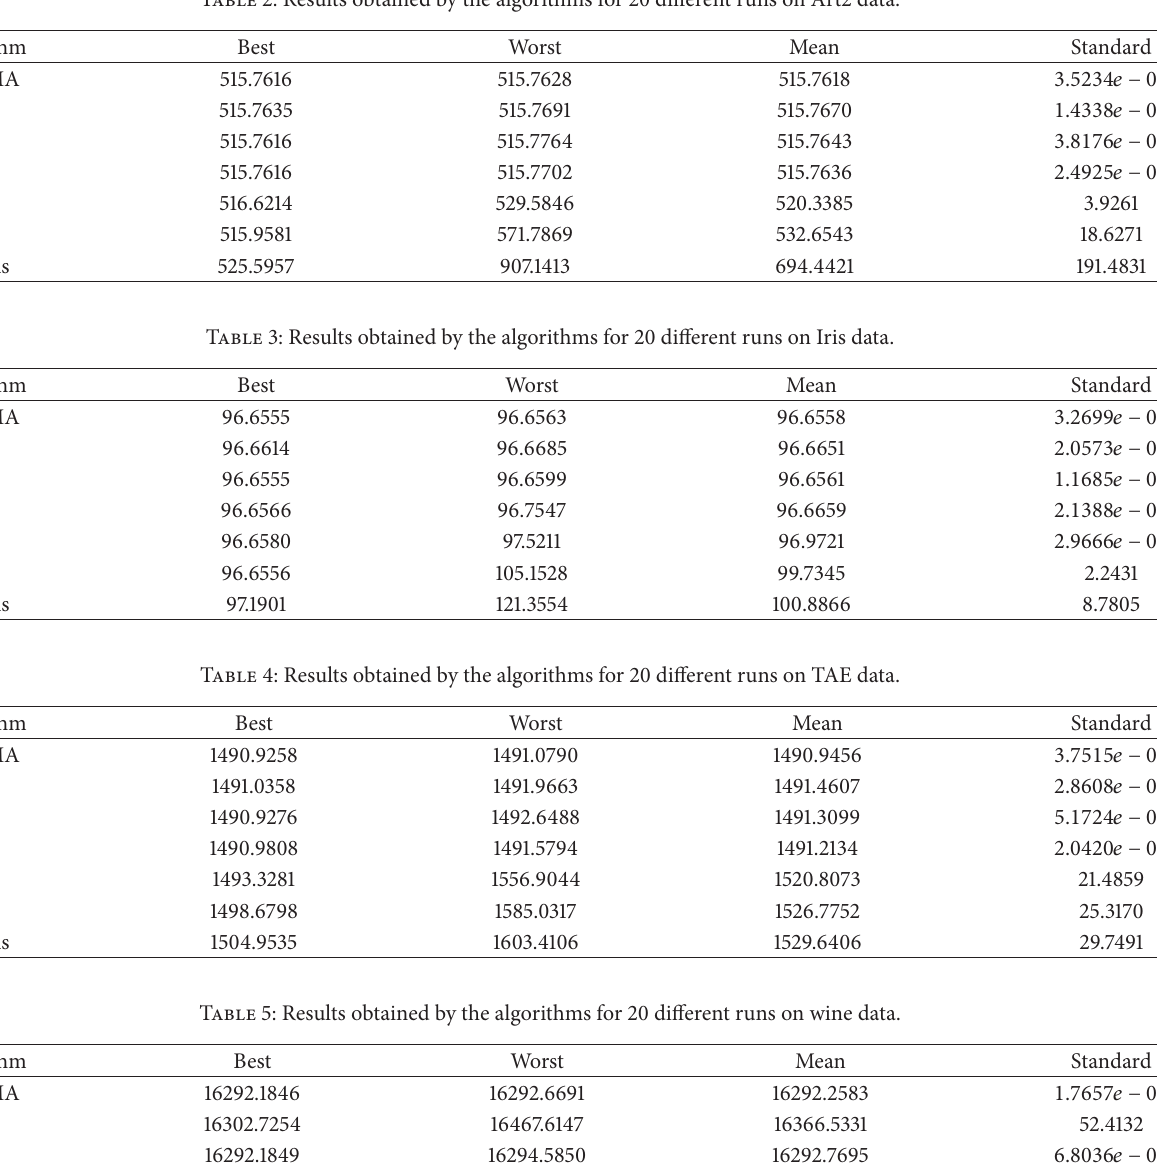
Table 2: Results obtained by the algorithms for 20 different runs on Art2 data.